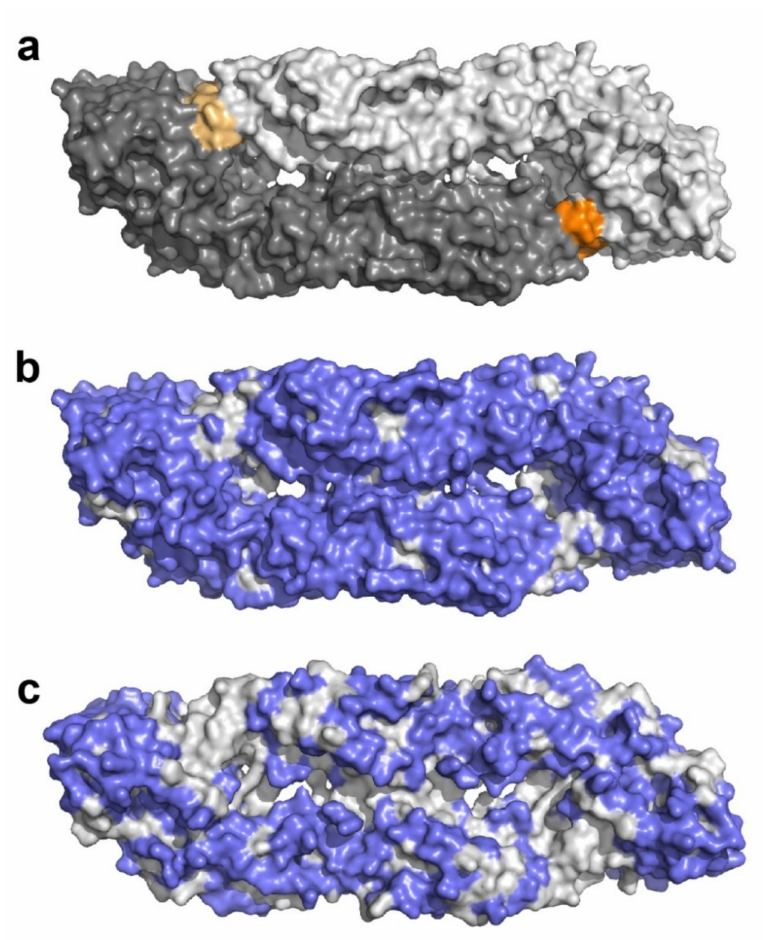
Figure 5. Surface representation of the Zika virus sE dimer in a top view. ( a ) The two monomers are shown in light and dark gray, the highly conserved fusion loops in light and dark orange, respec- tively. ( b ) Surface-exposed residues that differ between DEN1-4, Zika, Rio Bravo and TBE viruses highlighted in blue. ( c ) Surface-exposed residues that differ between DEN1-4 viruses highlighted in blue. Amino acid sequences of E proteins of the different flaviviruses listed in Table 1 were aligned with MUSCLE (https://www.ebi.ac.uk/Tools/msa/muscle/, accessed on 16 February 2021). The image was prepared with PyMol using the Protein data bank (PDB) files 6CO8 [20] and 1OAN